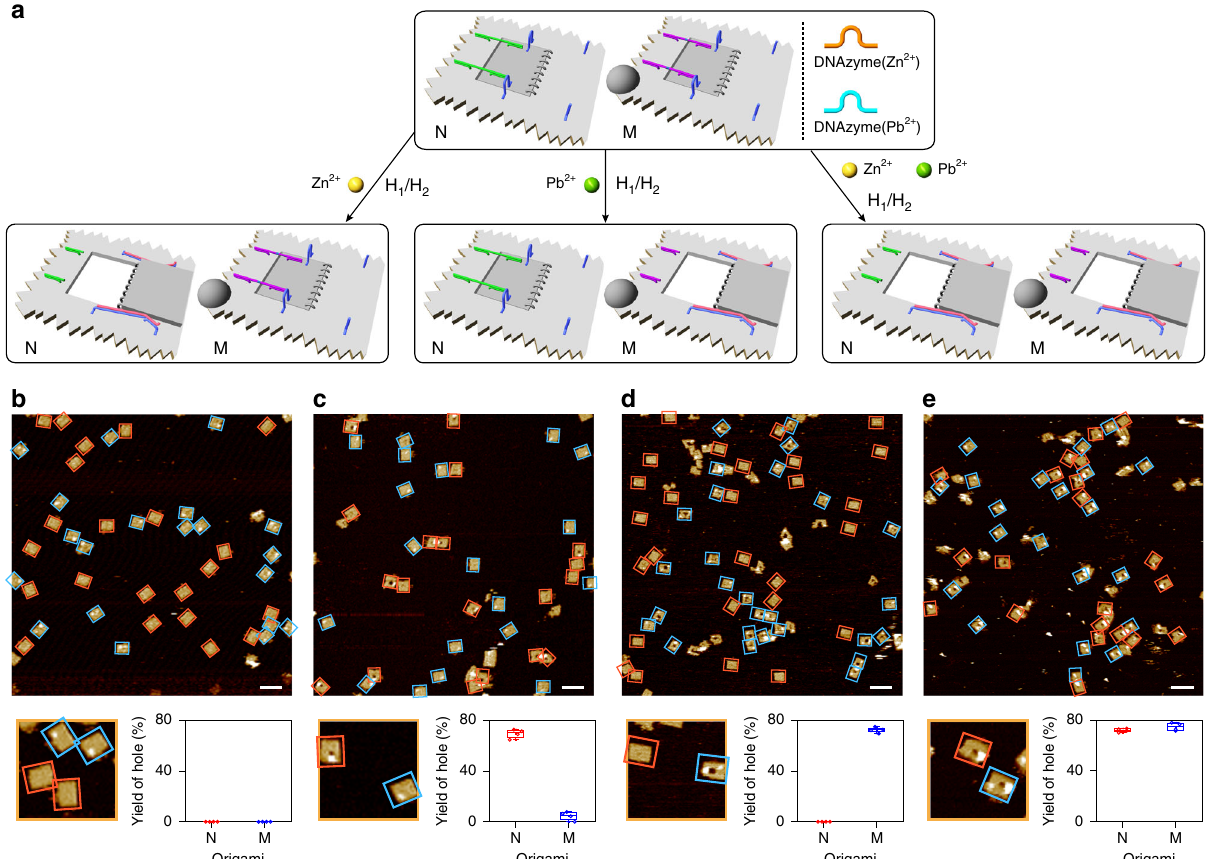
Fig. 2 Programmed and selective formation of nanoholes in the mixture of origami tiles N and M, dictated by the two DNAzymes. a Top, schematic mixture of the origami tiles N and M. Bottom-left, selective unlocking and formation of nanoholes in tiles N by activating the Zn 2 + -ion-dependent DNAzyme only. Bottom-middle, selective unlocking and formation of nanoholes in origami tiles M by activating the Pb 2 + -ion-dependent DNAzyme only. Bottom-right, the concomitant formation of nanoholes in the mixture of origami tiles N and M upon activation of the two Zn 2 + -ion- and Pb 2 + -ion-dependent DNAzymes. b AFM image corresponding to the mixture of locked origami tiles N and M. c AFM image of the origami tile mixture generated upon the activation of the Zn 2 + -ion-dependent DNAzyme (Cf. bottom-left in a ). d AFM image corresponding to the origami tile mixture generated upon the activation of the Pb 2 + -ion-dependent DNAzyme (Cf. bottom-middle in a ). e AFM image of the origami tile mixture generated upon the activations of Zn 2 + -ion- and Pb 2 + -ion-dependent DNAzymes (Cf. bottom-right in a ). Each of the AFM images is accompanied by a statistical analysis of the origami constituents N and M in the respective systems (for details, see Supplementary Tables 7 – 9). Error bars indicate the SD from the analyses of four imaged areas (2 μ m × 2 μ m). Scale bars: 200